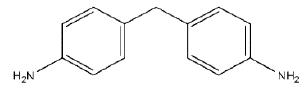
Figure 1. MDA molecule structure.